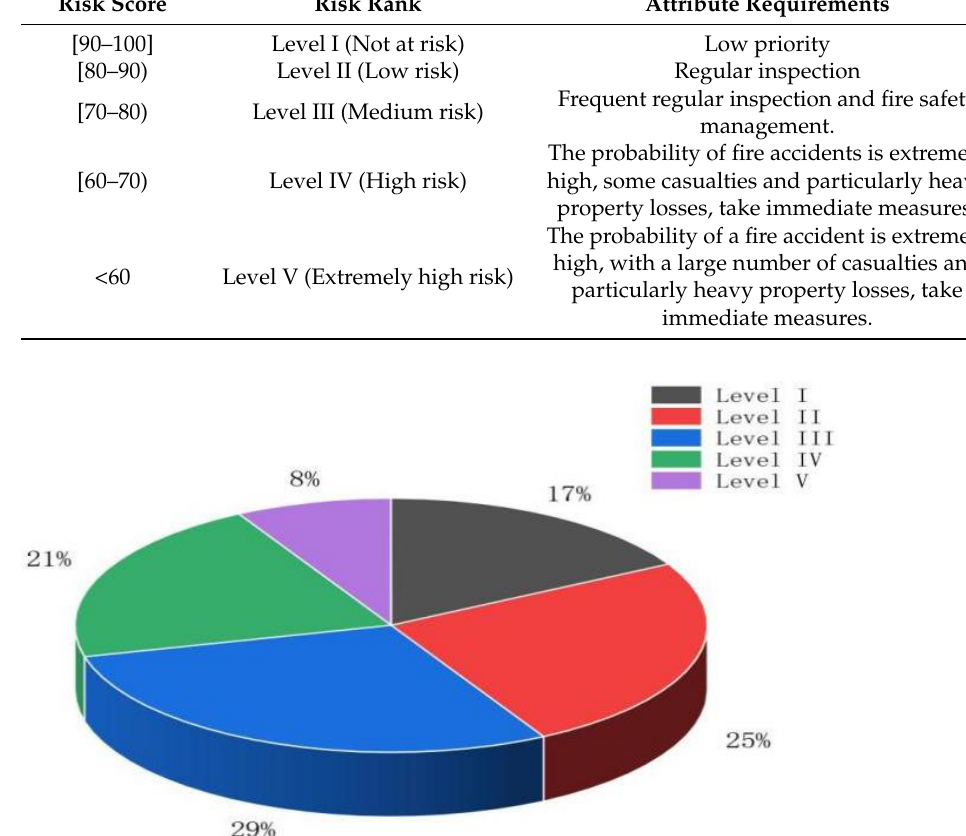
Figure 1. Distribution of fire risk levels for stadiums. Table 1. Classification of fire risk ranks.